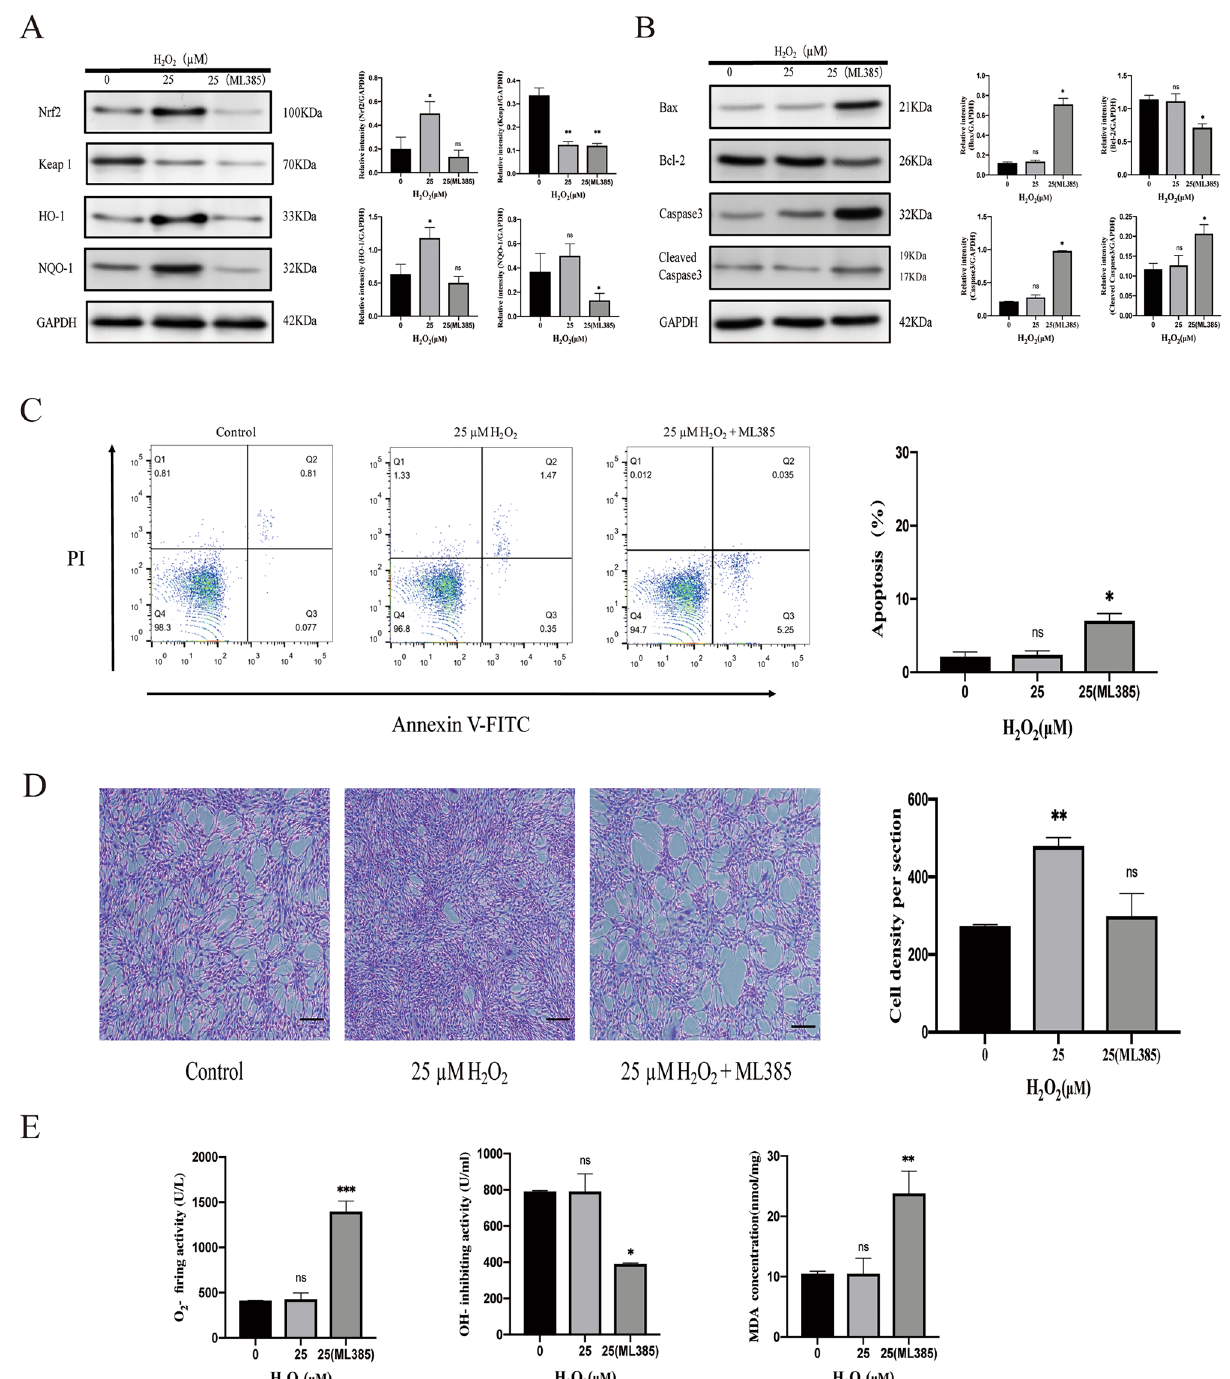
Figure 2. 25 μM H 2 O 2 pretreatment of MSCs can reduce apoptosis caused by ROS generation by activating the Nrf2/Keap1/ARE signaling pathway. ( A ) Immunoblotting assay determined the abundance of Nrf2, Keap1, HO-1, and NQO-1 proteins, and semi-quantitative analysis of the related proteins. ( B ) Immunoblotting assay determined the abundance of Bax, Bcl-2, Caspase 3, and Cleaved Caspase3 proteins, and semi-quantitative analysis of the related proteins. ( C ) Representative images of flow cytometric analysis by annexin V-FITC/ PI dual staining. Apoptotic cells are represented as the percentage. ( D ) Crystal violet staining assessed the cell density are shown, quantitative analysis of cell density. Magnification: × 40. Scale bar, 200 μm. ( E ) The quantitative evaluation of oxidative stress in MSCs including O 2− , OH − , and MDA. The data are expressed as the mean ± SD (n = 3). * P < 0.05, ** P < 0.01, and *** P < 0.001; ns no